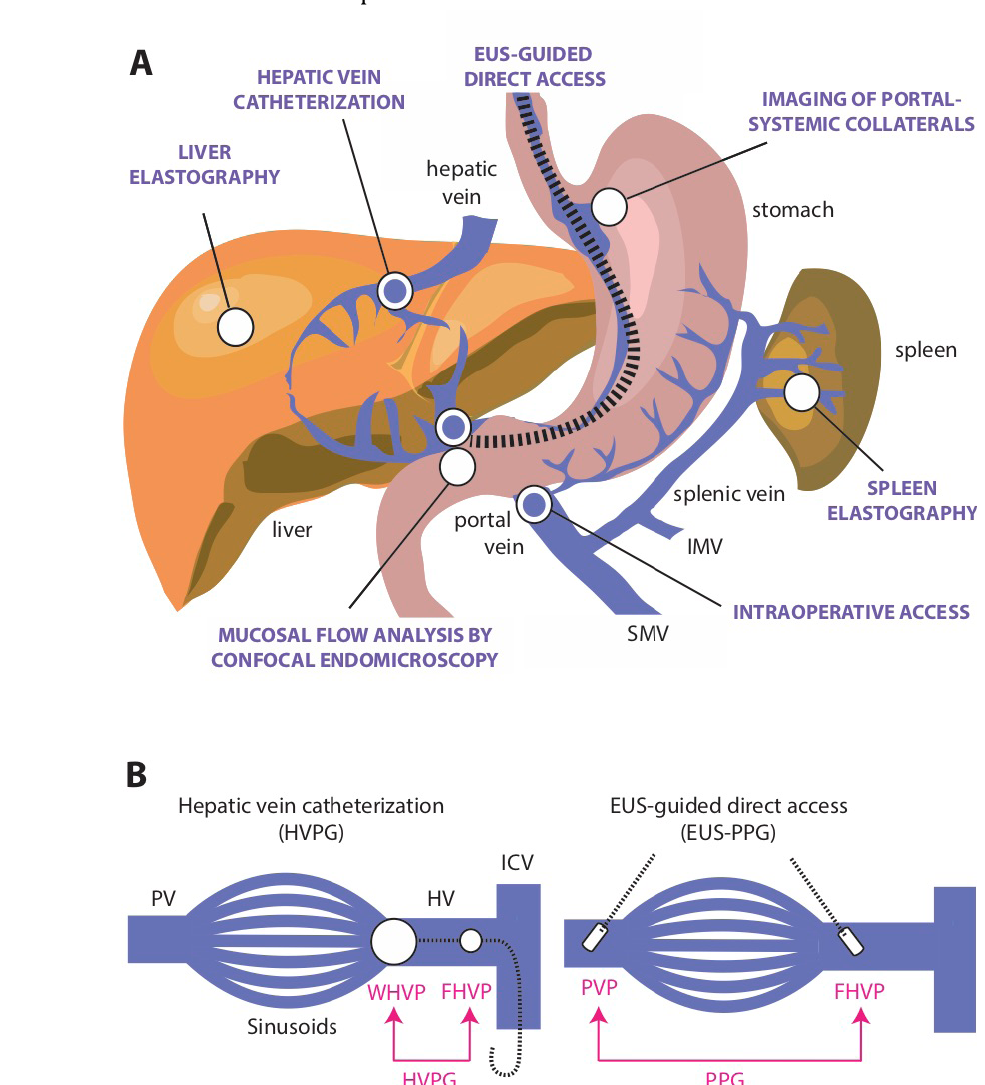
Figure 4. Direct and indirect methods for the assessment of portal hypertension. A. Several minimally invasive or non-invasive approaches (indicated by white circles) have been developed to estimate portal venous pressure, including endoscopic visualization or imaging of portal-systemic collaterals by various methods based on abdominal sonography [28, 63, 64, 79], computer tomography [80] and multi-parametric MR imaging [81]; tissue stiffness assessment of the liver and spleen by vibration- controlled transient elastography or 2-dimensional (gradient-recalled echo) MR elastography [65, 82-84]; and analysis of mucosal vascular pattern and flow by confocal endomicroscopy [78]. Direct access methods (indicated by blue circles) include HVPG measurement, which is the reference technique for measuring portal hypertension, and the occasional opportunity to obtain intraoperative access to the portal vein [57, 85, 86]. EUS-guided portal and hepatic vein access is an emerging method to provide safe and direct measurement of portal pressure gradient (PPG) [87, 88]; B. Comparison of the classic hepatic venous pressure gradient (HVPG) method using indirect access through the hepatic vein to estimate PVP and endoscopic ultrasound (EUS)-guided assessment of through direct access of the portal vein and hepatic vein. To calculate HVPG, a balloon-tipped central vein catheter is inserted into a hepatic vein tributary where retrograde occlusion detects WHVP and keeping the catheter “free” in the hepatic vein detects FHVP [57, 85]. In cirrhotic patients, WHVP is almost identical to PVP and the pressure difference between wedged and free-floating catheter positions defines HVPG [89]. To calculate PPG, the portal and hepatic vein is accessed through insertion of a digital pressure detection device by EUS-guided technique to calculate the difference between PVP and FHVP [87, 88]. SMV: superior mesenteric vein; IMV: inferior mesenteric vein; PV: portal vein; HV: hepatic